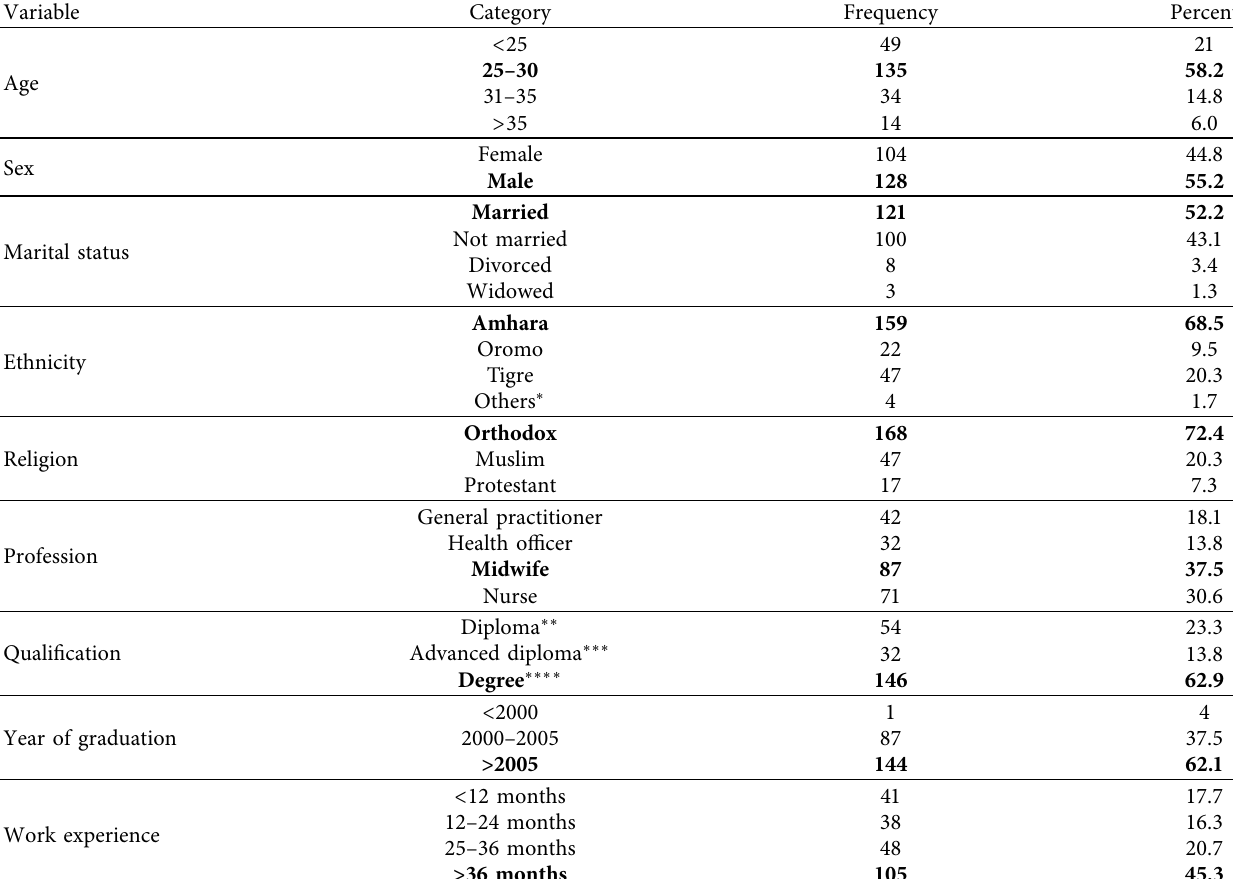
Table 2: Sociodemographic characteristic of participants, 2020.